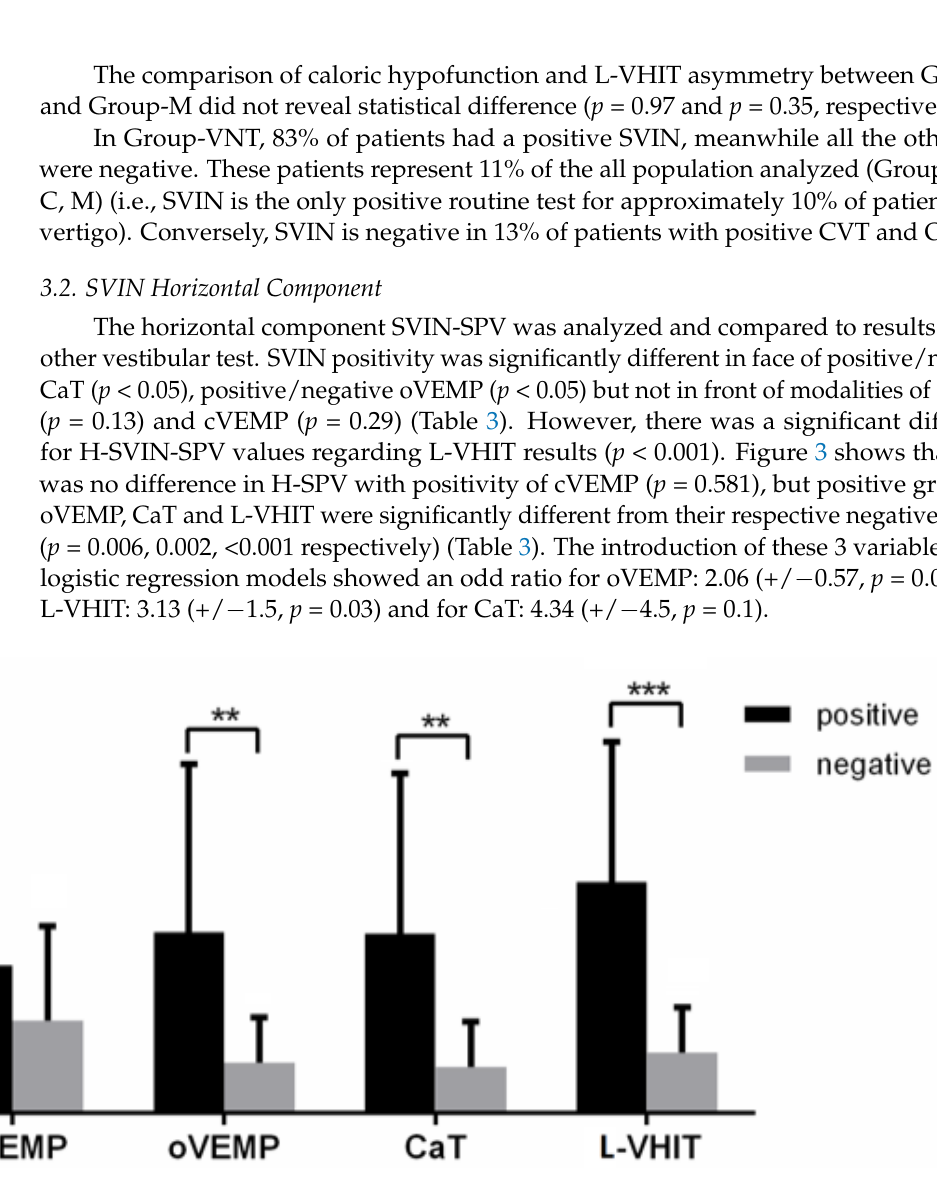
Figure 3. H-SPV bar chart with standard error comparison between positive and negative results of vestibular tests. (**: p < 0.01, ***: p < 0.001).